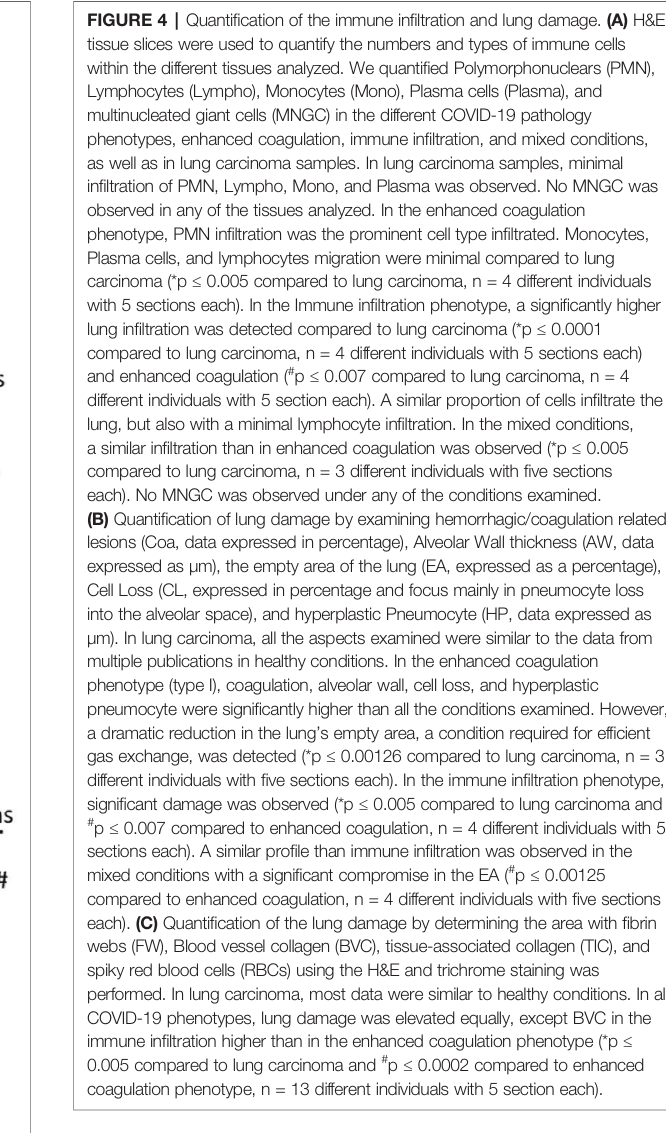
#p ≤ 0.00106 compared to enhanced coagulation n=11, different individuals with 15-20 serial sections). Most CD8 + cells were also positive for CD3 + , corresponding to cytotoxic/natural killer T cells (83.06 ± 8.97%) instead of other CD8 + cells such as thymocytes and dendritic cells. These data indicate that in at least all the deathly COVID-19 cases analyzed here, a poor CD3 + and cytotoxic CD8 + response was observed.